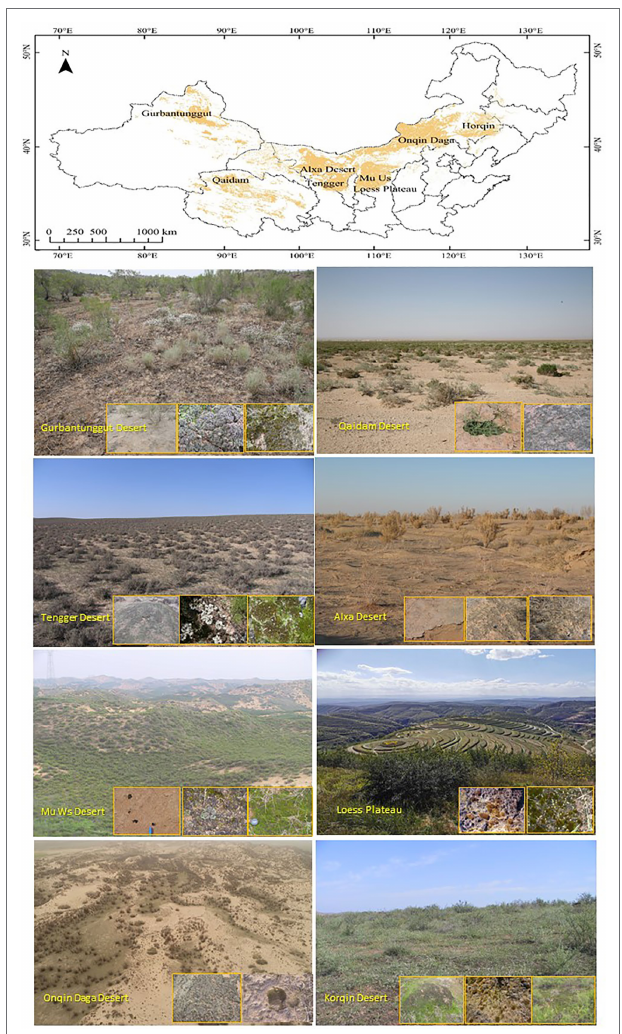
FIGURE 2 | The main research sites and types of biocrust of Chinese deserts and the Loess